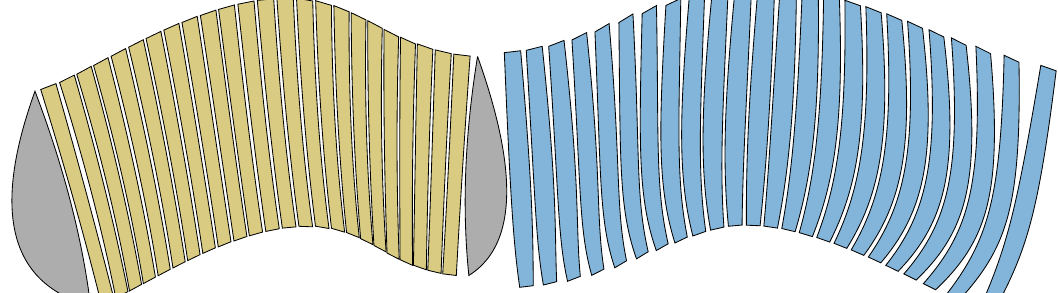
Figure 36. Unrolled panels for Figure